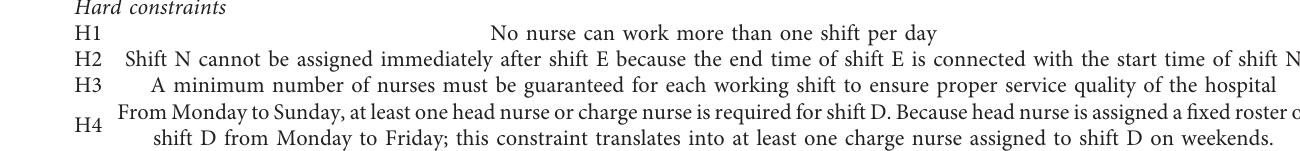
Table 4: Description of hard and soft